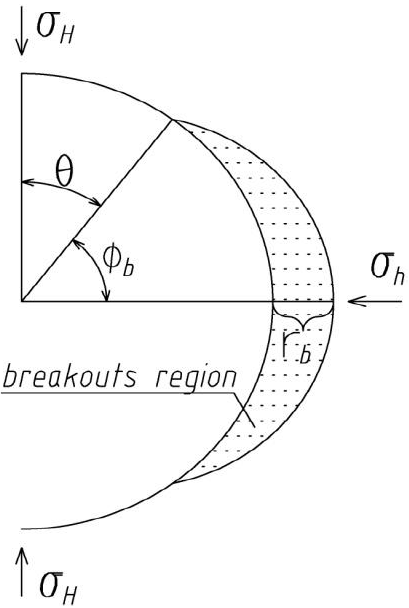
Figure 4. Schematic of a wellbore breakout shape.